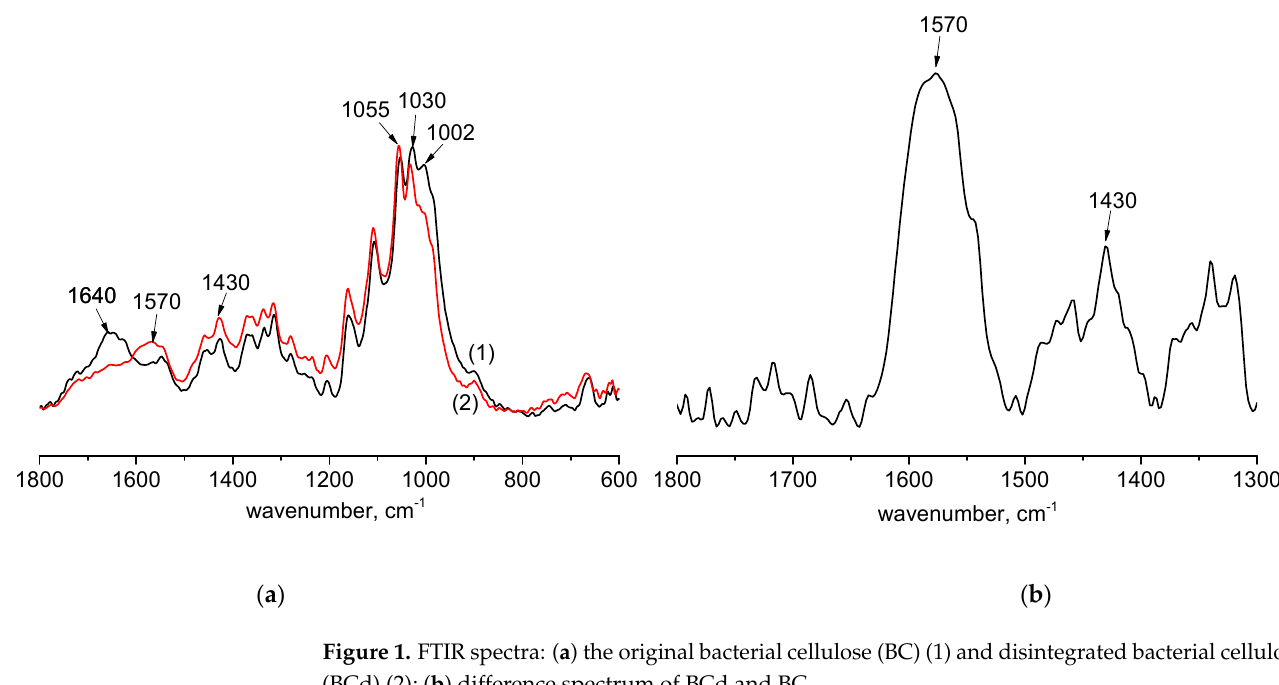
Figure 1. FTIR spectra: ( a ) the original bacterial cellulose (BC) (1) and disintegrated bacterial cellulose (BCd) (2); ( b ) difference spectrum of BCd and